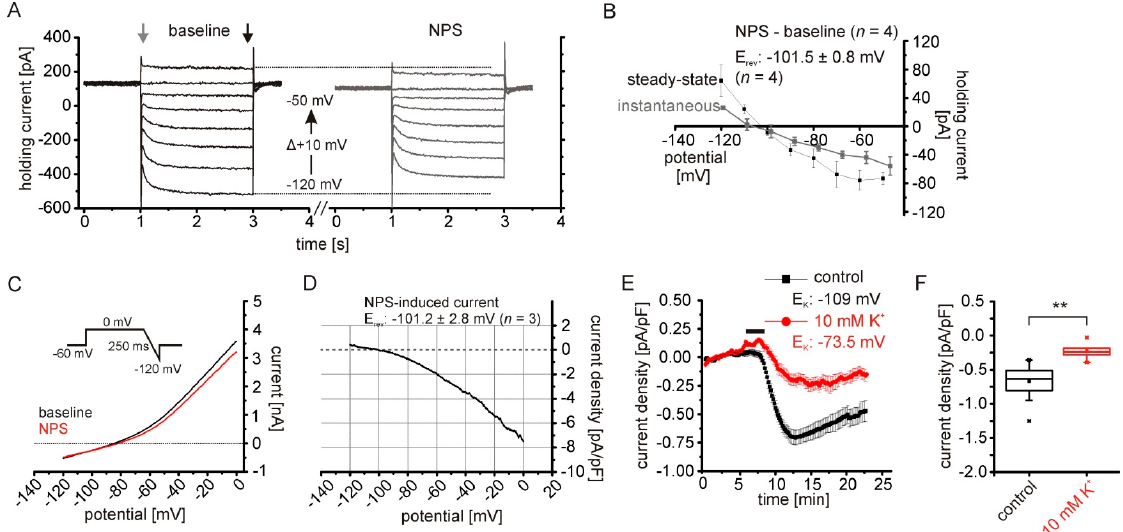
Figure 2. The NPSR1-dependent current results from reduced potassium conductances. ( A ) Voltage steps ( − 120 mV to − 50 mV; Δ + 10 mV; 2 s duration) from a holding potential of − 60 mV in the voltage-clamp mode. Recordings were done under baseline conditions and in the presence of 150 nM NPS. For both conditions, baseline and in the presence of NPS, the steady-state current (black arrow) and the instantaneous current (grey arrow) were analyzed. ( B ) Plot of the I–V curves calculated from step protocols. The NPS-induced current was calculated as: current NPS -current baseline . ( C ) Example of hyperpolarizing ramp recordings (0 mV to − 120 mV; 250 ms) from aBA PNs during baseline conditions (black) and in the presence of 150 nM NPS (red). ( D ) Mean NPS-induced current calculated from three recordings. The resultant current was calculated: current NPS -current baseline . ( E ) Time course of the NPS-induced current during control conditions (black), and with elevated potassium concentration (10 mM; red) in the ACSF. ( F ) In the presence of 10 mM K + , the NPS-induced current is significantly reduced compared to control conditions. ** p <